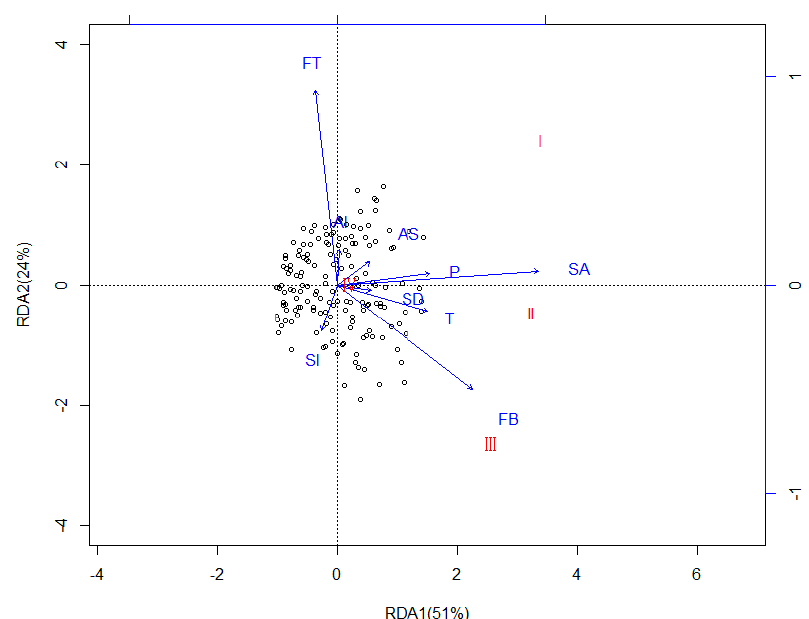
Figure 9. Redundancy Analysis (RDA) showing the relationships between the CWD diameter classes and effect factors in the different samples on the Huoditang Experimental Forest Farm in the Qinling Mountains (China). Arrows indicate effect factors: FT = Forest type; FB = Forest biomass; AS = Aspect; Al = Altitude; SA = Stand age; Sl = Slope; SD = Stand density; T = Annual average temperature; P = Annual average precipitation. I: 10–20 cm, II: 20–30 cm, III: 30–40 cm, and IV: >40 cm. CWD diameter class names in red indicate the diameter class’s vector endpoints. Forests 2017 , 8 , x FOR PEER REVIEW